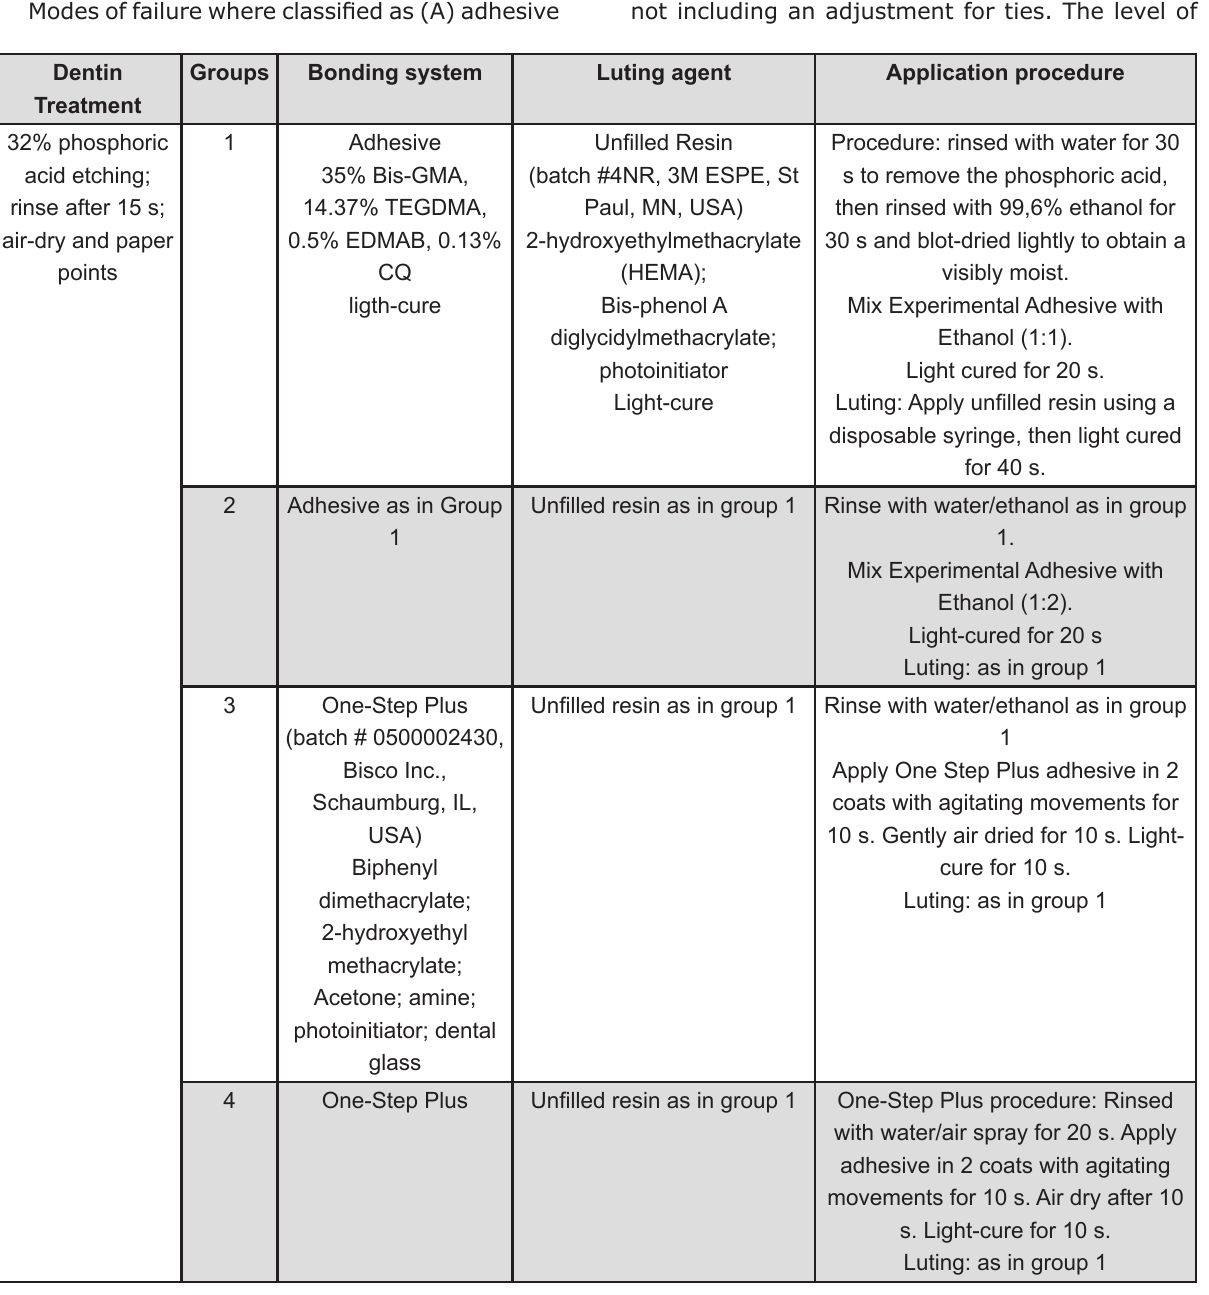
Figure 1- Chemical composition and application mode of the materials used in the